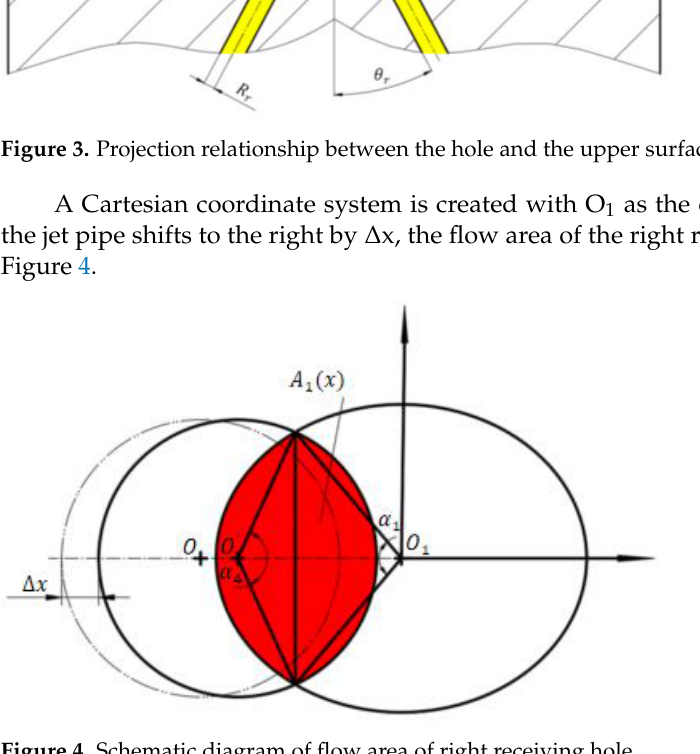
Figure 4. Schematic diagram of flow area of right receiving hole.